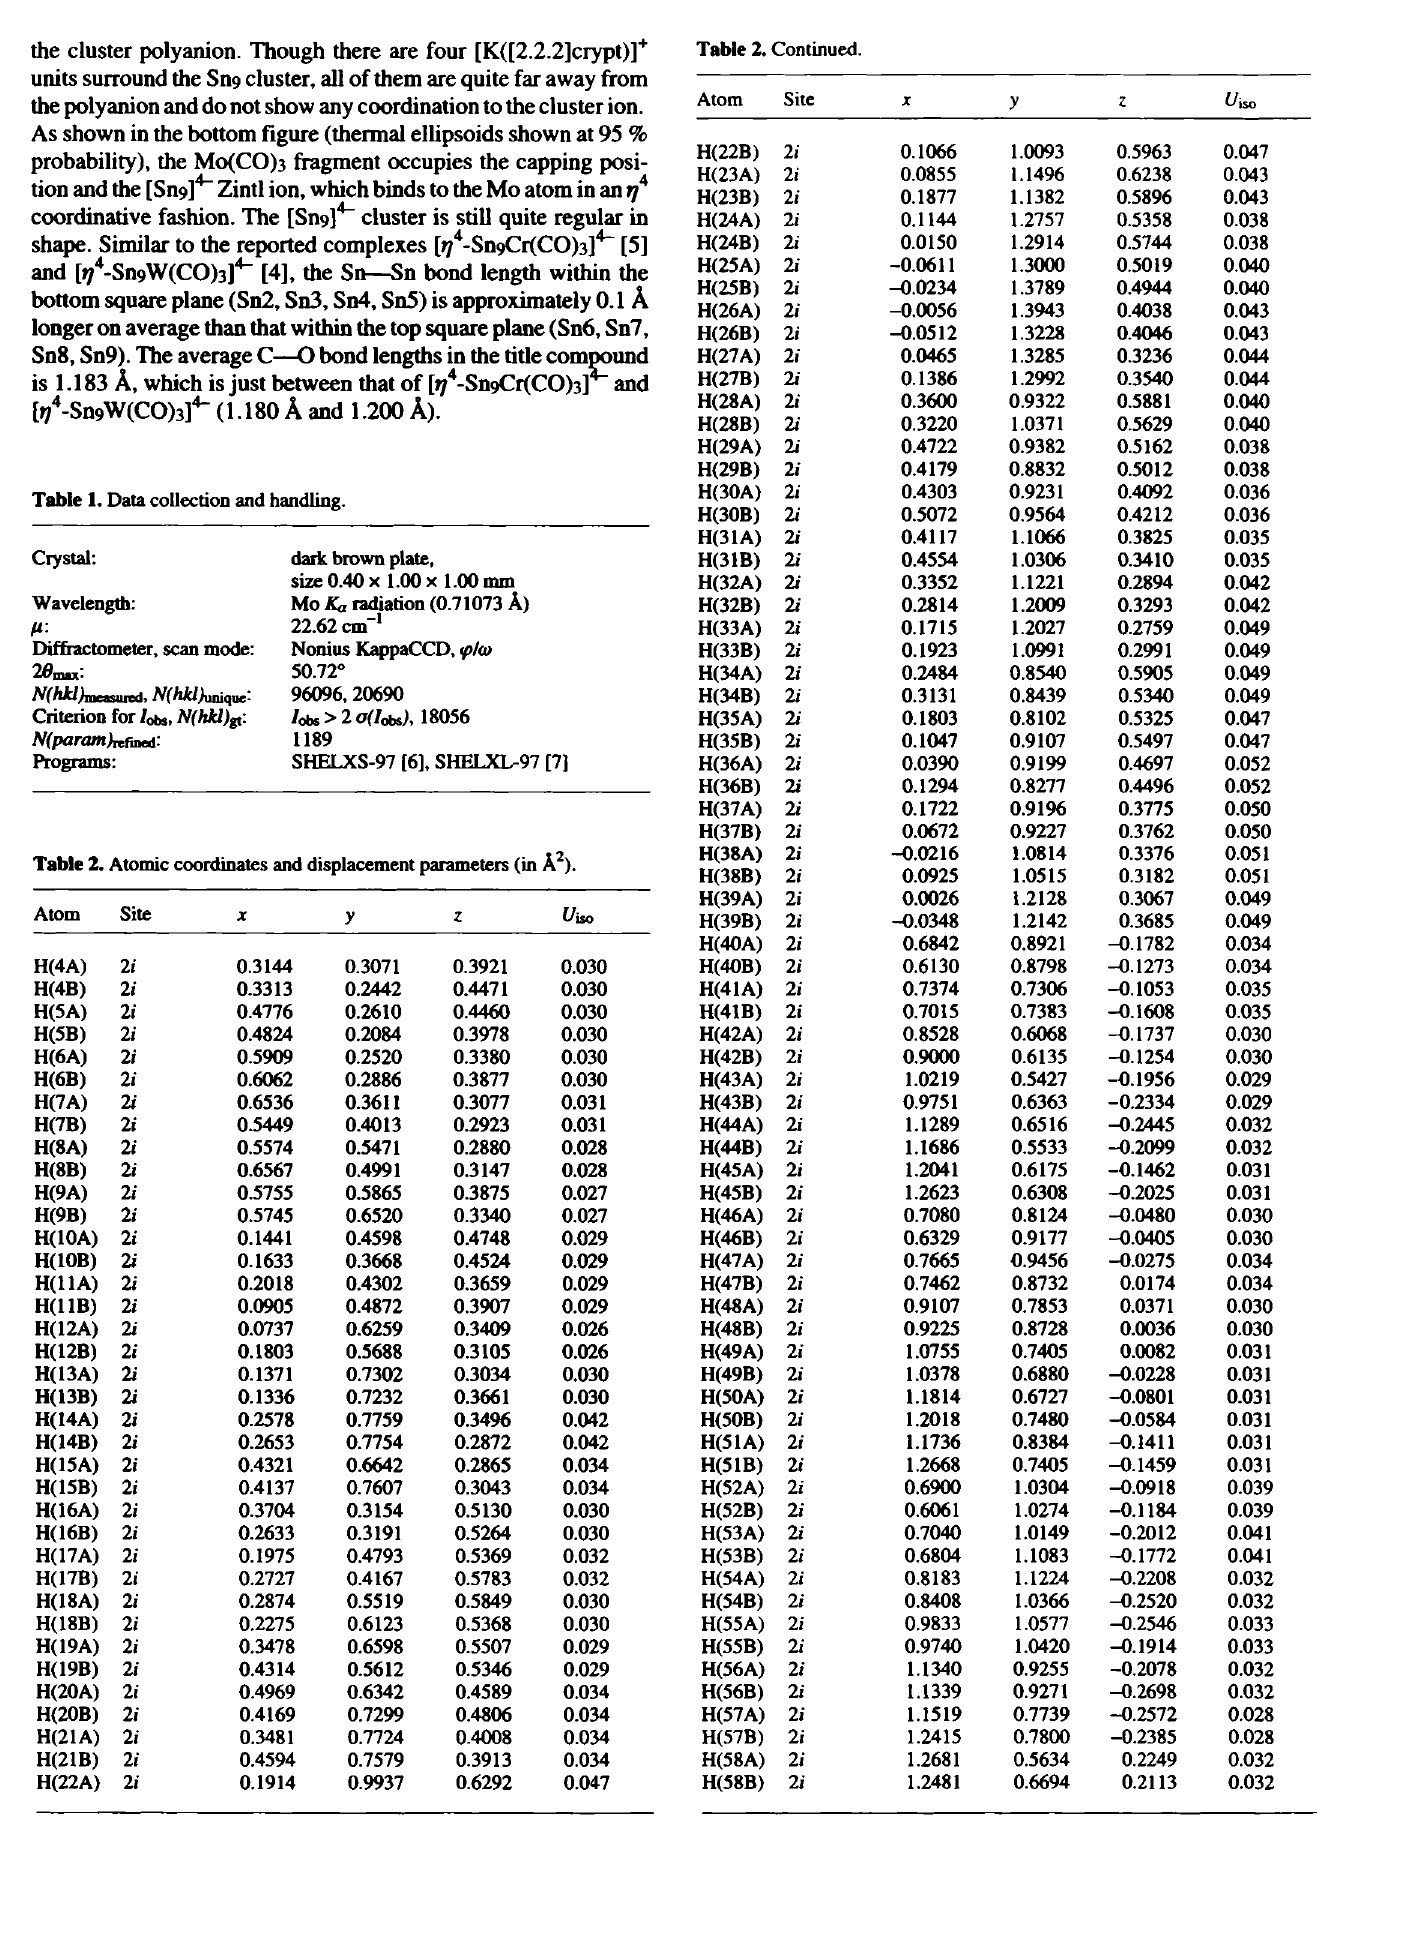
Table 1. Data collection and handline.